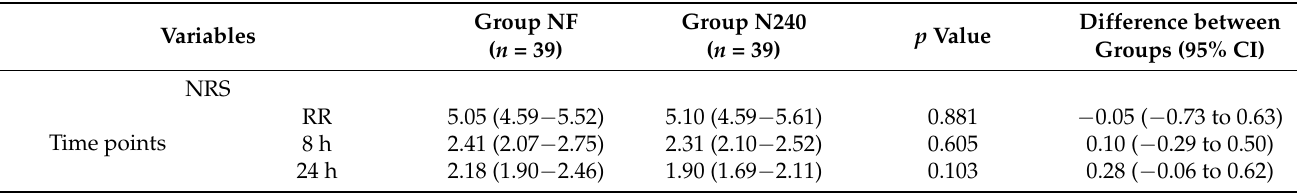
Table 2. Test for non-inferiority between nefopam and nefopam-fentanyl in patient-controlled analgesia following laparoscopic cholecystectomy.